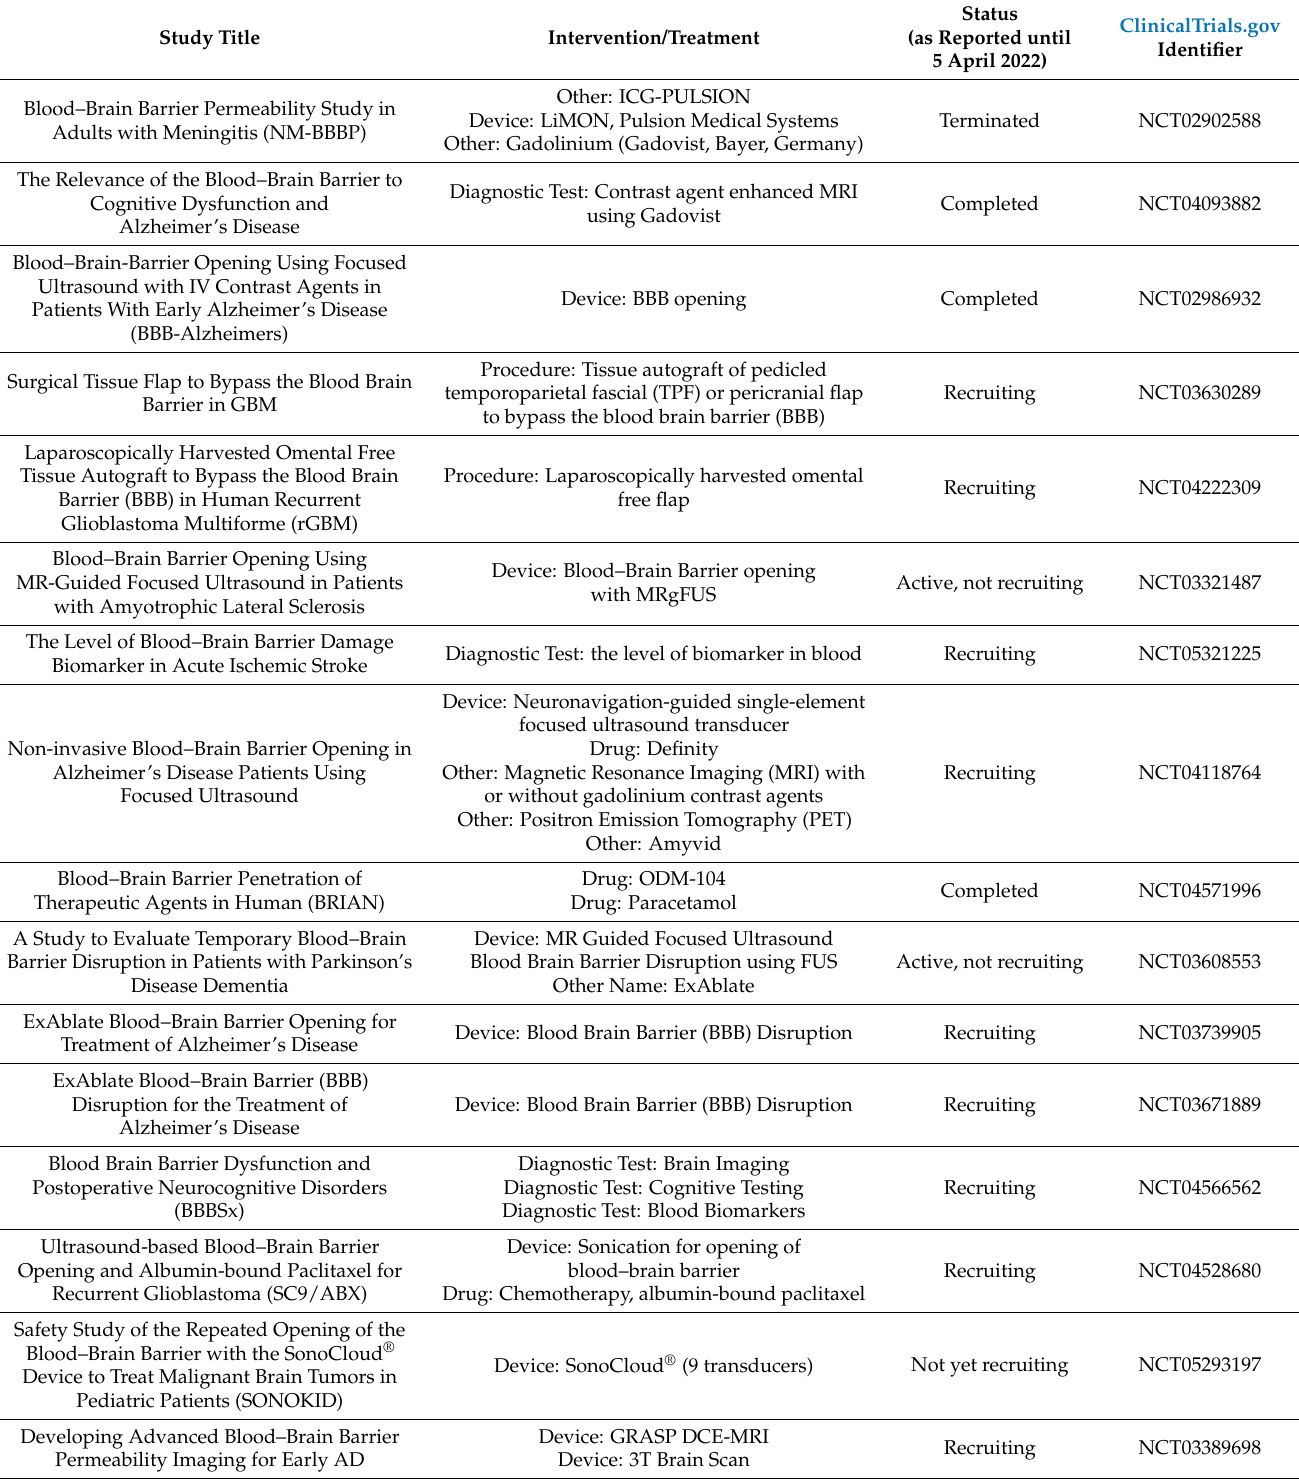
Table 3. Examples of clinical trials investigating BBB-related